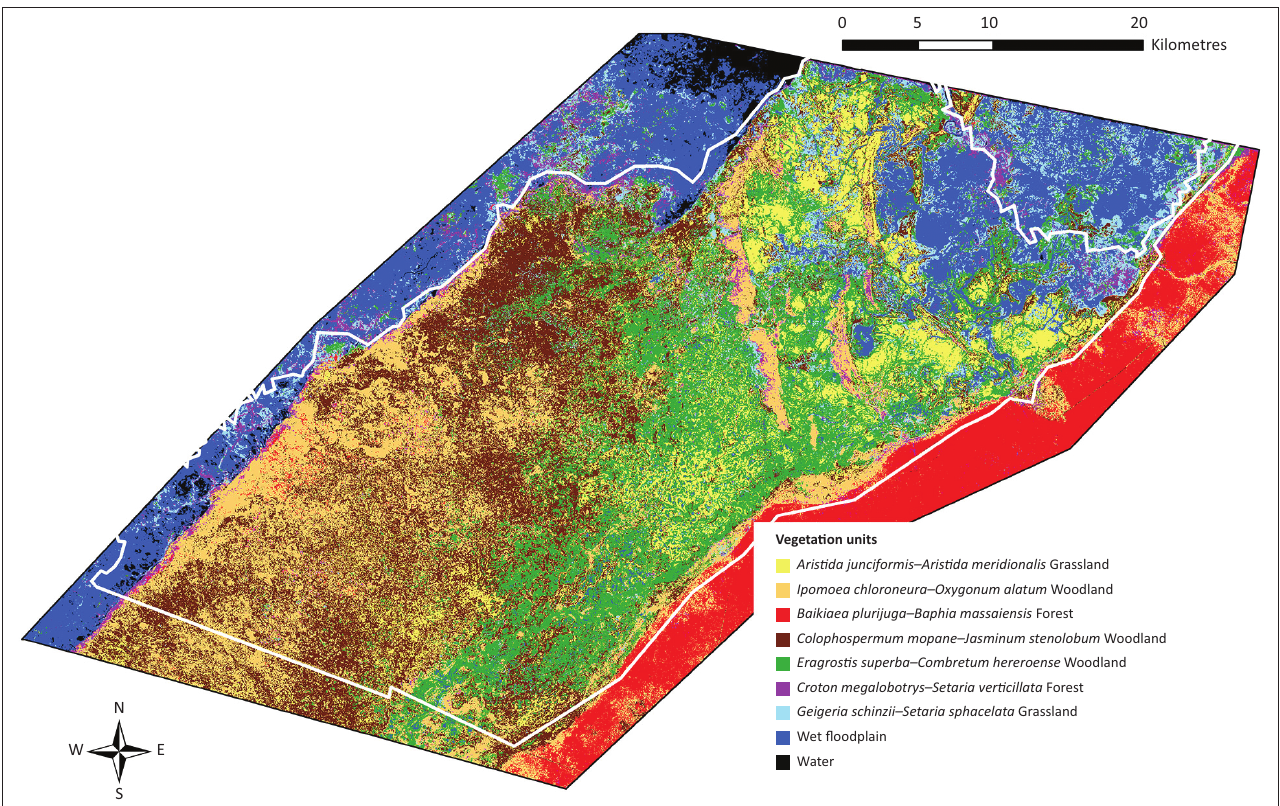
FIGURE 4: Vegetation map of the Chobe Enclave, delineated by the white line (a version in GIS file format is available upon request from the corresponding author).